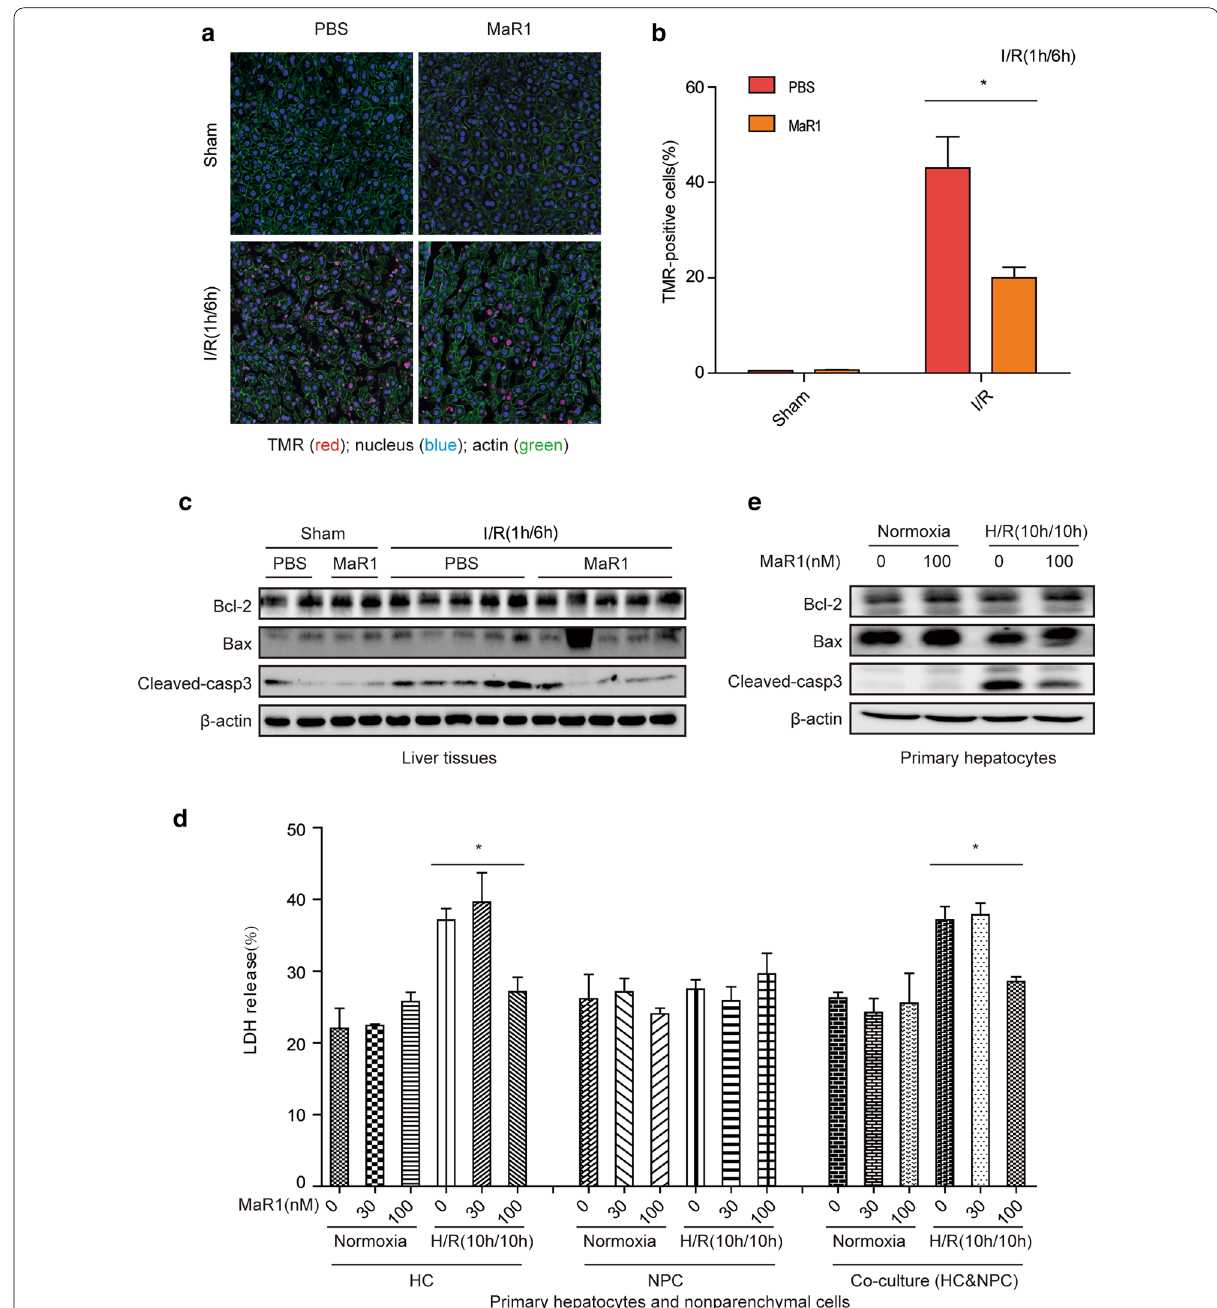
Fig. 2 MaR1 reduces hepatocyteapoptosis during hepatic I/R injury. a Confocal images of TMR (red), nucleus(blue), and F-actin (green) in liver sections obtained from PBS or MaR1-treatedmice subjected to sham surgery or 1 h ischemia/6 h reperfusion (scale bar 25 μm). b Percentage of = TMR-positive cells per liver section (n 3 or 4/gp). c Western blot analysis of apoptosismarkers (Bax, Bcl-2 and cleaved-caspase3) in liver tissues = from PBS- andMaR1-treated mice that underwent sham operation or liver I/R insult (1 h/6 h). d LDH release in primary mouse HCs,NPCs, or HC/NPC co-cultures subjected to normoxia or 10 h hypoxia (1% O2)/10 hreoxia (H/R 10 h/10 h) without (0) or with pretreatment with 30 or 100 nM MaR1. e Western blot analysis of Bcl-2, Baxand cleaved-caspase3 in primary mouse HCs treated with normoxia or H/R without(0) or with 100 nM MaR1 given prior to H/R. Images representative of at least 3separate experiments. All data are shown as mean SEM. * P < ±